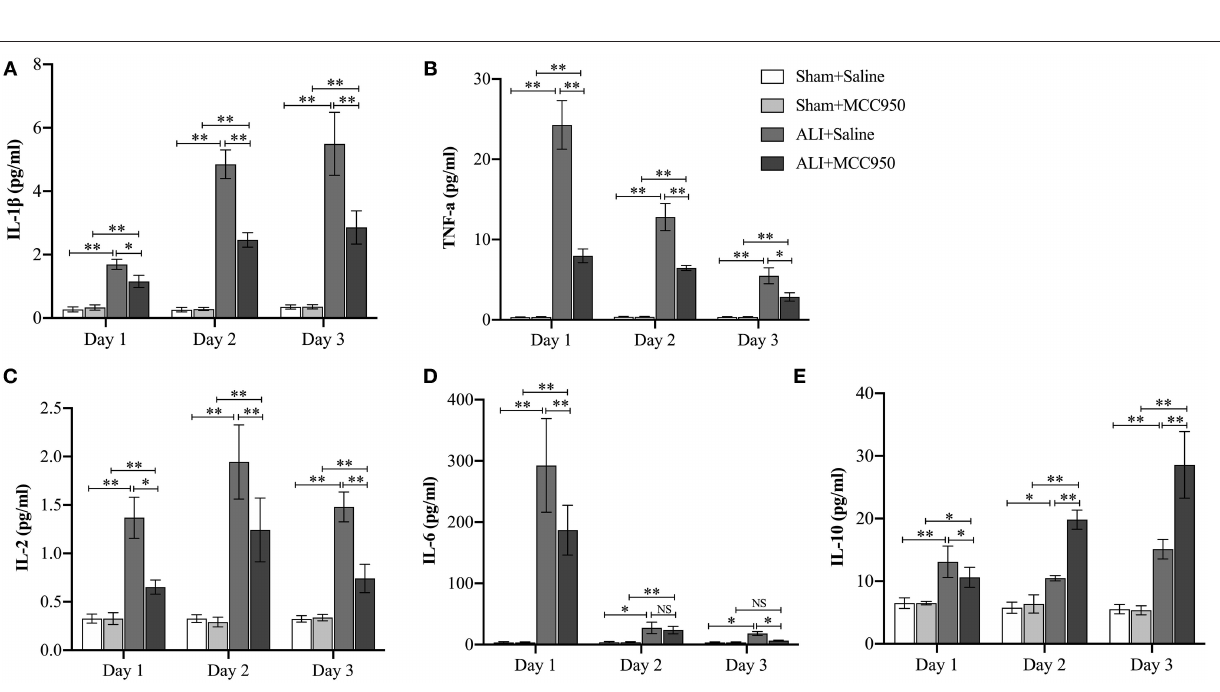
Frontiers in Medicine |